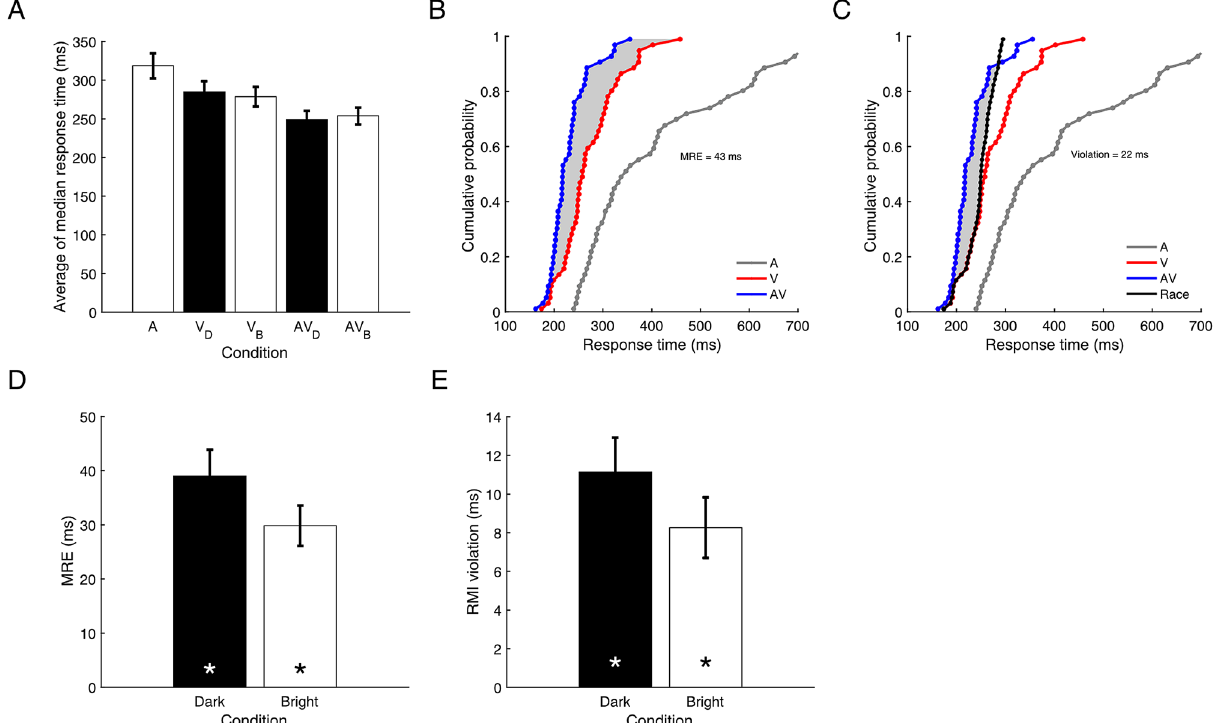
Figure 2. ( A ) The average of the median response times in the auditory (A), visual dark (V D ), visual bright (V B ), audiovisual dark (AV D ), and audiovisual bright (AV B ) condition in the Response block in Experiment 1. Significant differences between conditions are not indicated in panel ( A ). See the text for information on RT differences. ( B ) A single-participant example of the area between Grice’s bound 31 and the AV CDF (in grey) indicating the amount of MRE. ( C ) A single-participant example of the area (grey shading) between the race model (Miller’s bound 10 , black line) and the AV CDF (blue line) indicating the amount of RMI violation. ( D ) The amount of multisensory response enhancement for bright and dark AV targets. ( E ) Race model inequality violation for bright and dark targets. Error bars indicate standard errors. Asterisks indicate BF +0 >